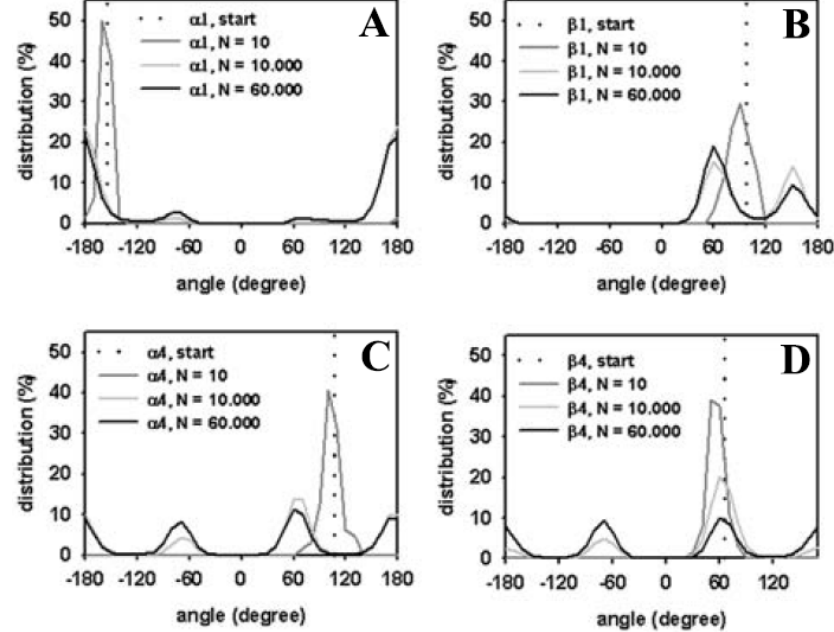
Figure 6. Head group torsions of DPPC in the membrane. Head group dihedral angles were defined as in Vanderkooi et al . [84], and as given in the legend to Figure 5. The starting value is defined by the initial conformation (dotted lines, “start”; compare Figure 2A). The percentage of occupation was calculated as function of torsion angle (in degree) after 10 (“ N = 10”, dark grey line), 10,000 (“ N = 10,000”, light grey line), 60,000 (“ N = 60,000”, black line) MC steps, respectively. ( A ) shows the torsion around the bond connecting atoms 6 and 7 ( α ); ( B ) around the bond connecting atoms 8 and 9 ( β ) 1 1 ) and ( D ) is the torsion angle distribution ( C ) around the bond connecting atoms 3 and 4 ( α 4 around the bond connecting atoms 11 and 12 ( β 4